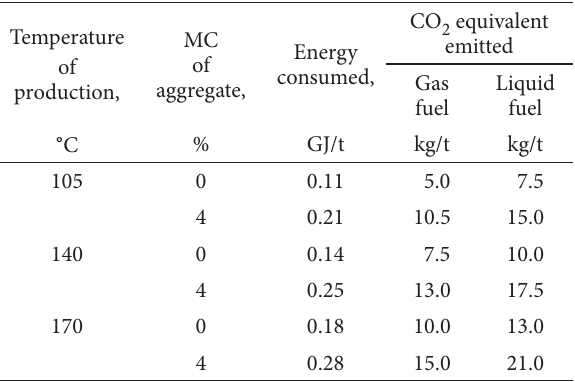
Table 3. Data for model (from information presented in West et al. (2014)) Temperature